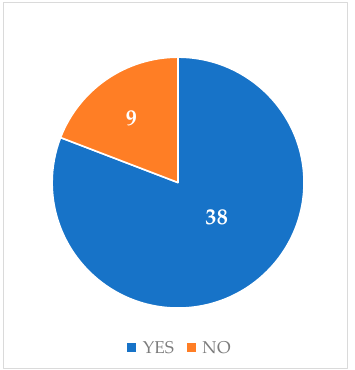
Figure 9. Questionnaire results on replacing the textbook with the game.